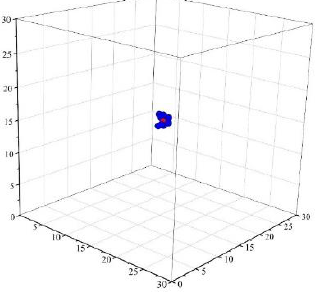
Figure 6. Wolves updating close to the best